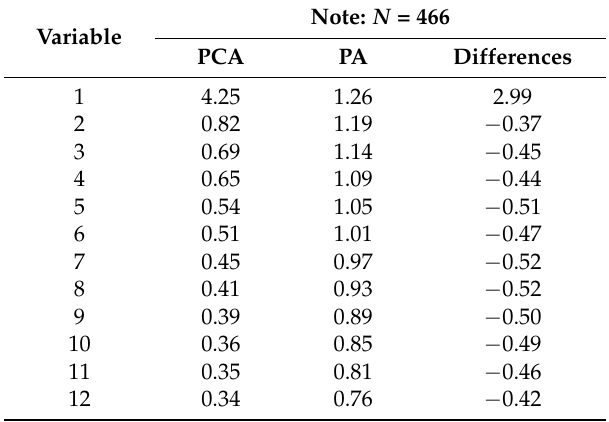
Table 1. Parallel Analysis for the Adventure Behavior Seeking Scale Note: N = Variable